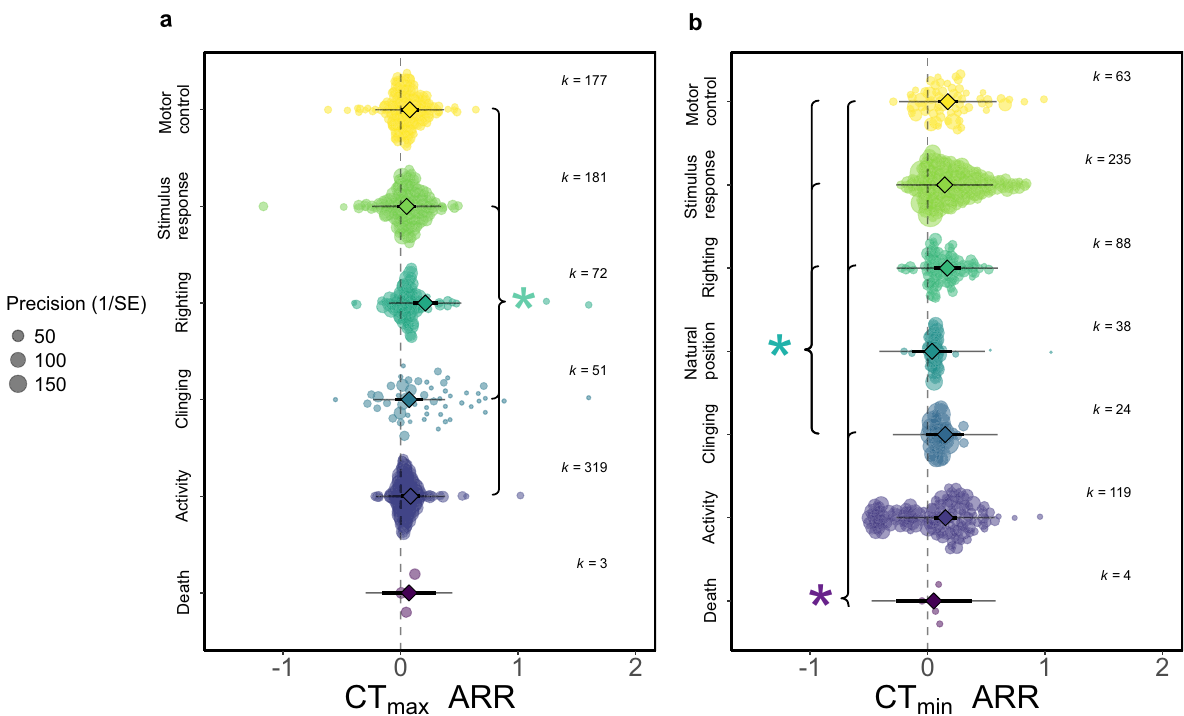
Fig. 4 | Difference in acclimation response ratio (ARR) between assay endpoint de fi nitions of critical thermal limits, a CT max (k=803) and b CT min (k=571). The endpointoftheassayisthebehaviouratwhichthecriticalthermallimitistaken.Excluding ‘ Death ’ ,variablescanbe readas ‘ Lossof …’ .95%con fi dence intervals(95%CIs) aredepictedinheavyblacklines(sometimeshiddenbythemeandatapoint,depictedbyadiamondsymbol),predictionintervalsinthinblacklines.Thesizeofeachdata pointisproportionaltotheprecisionofthestudy(1/SE(StandardError)).k=numberofeffectsizespergroup.Asteriskindicatesthat95%CIsdonotoverlap,bracketson the right show that the reference group is larger than marked groups, on the left,